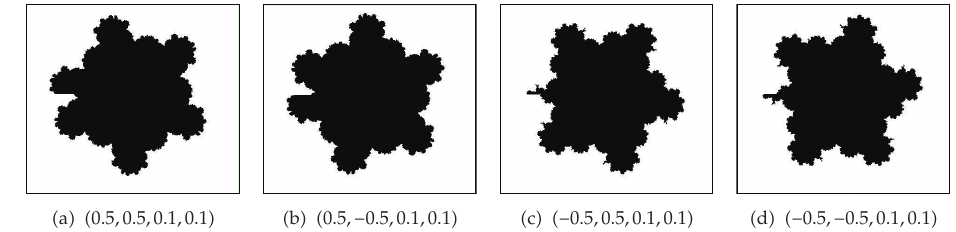
Figure 14: The generalized J sets perturbed by multiplicative noise when α (cid:6) 5 . 5, θ ∈ (cid:7) − π,π (cid:4) .